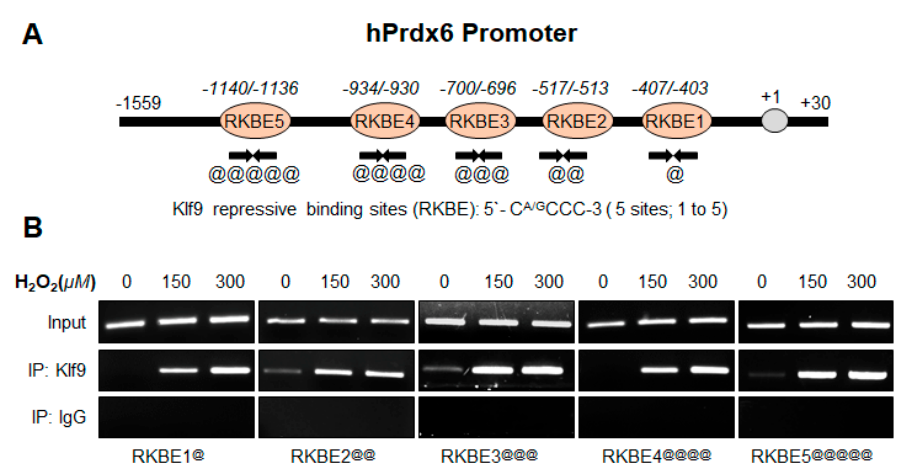
Figure 8. In vivo DNA binding (ChIP) assay disclosed that H 2 O 2 treatment stimulated Klf9 binding to its new target gene, Prdx6 in dose-dependent fashion. ( A ) Diagrammatic illustration of Prdx6 promoter containing repressive Klf9 binding element (RKBE). ( B ) hLECs treated with different concentrations of H 2 O 2 for 3h as indicated. Pulled DNA fragments with Klf9 antibody were subjected to PCR analysis for RKBE site(s) using primers that recognized a fragment of Prdx6 promoter containing RKBE as indicated. Primers used for amplification of specific region containing Klf9